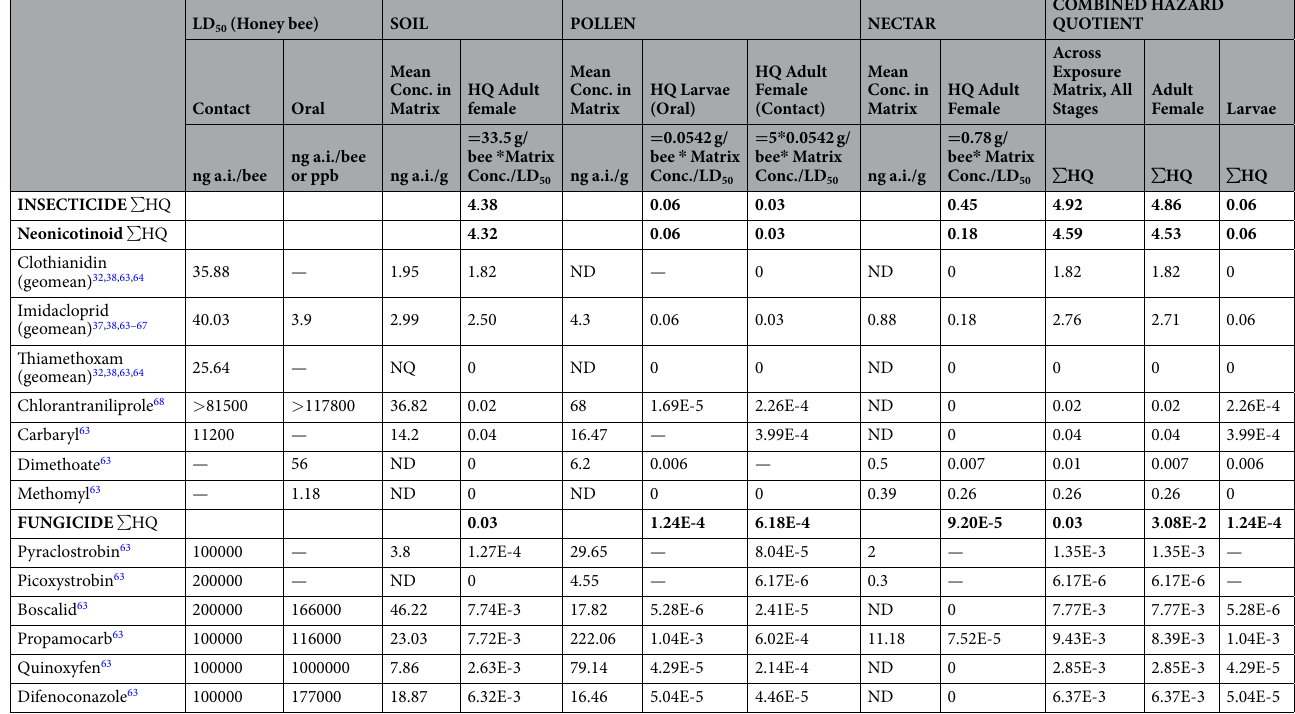
Table 1. Hazard quotients (HQ) for each active ingredient, and pesticide type (insecticide, fungicide) in three exposure matrices (soil, pollen, nectar) and both developmental stages (adult female or larvae) based on honey bee LD 50 values taken from the literature 32,38,63–68 and mean residue concentration in the exposure matrices for all pesticide residues found detected on 18 Cucurbita- crop farms in Ontario in 2016. Numbers shown in bold face are combined hazard quotients for a pesticide type, an exposure matrix, or a developmental stage. Where “ND” is indicated, residues were not detected, where “NQ” is indicated, residues were not quantifiable in samples. a.i. = active ingredient. A dash ( − ) indicates no